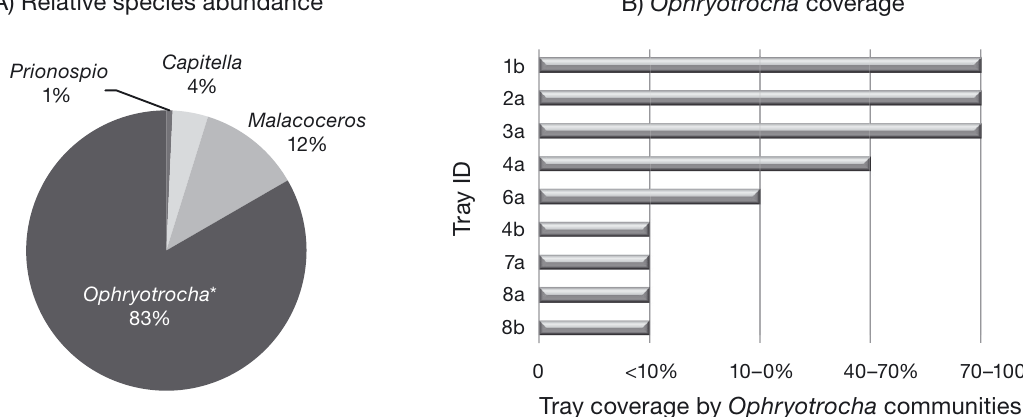
Fig. 2. Polychaete development on benthic cultivation trays. (A) Relative species abundance (% based on number m −2 ) deter- mined after retrieval of the cultivation trays. Abundance of Ophryotrocha spp. is underestimated, as an unknown fraction of in- dividuals was lost during retrieval from deployment depth to the surface. (B) In situ measurement of Ophryotrocha coverage (%) on each tray as determined by video analysis prior to sampling (4 wk deployment) and defined by the coverage of the tray sur- face by the Ophryotrocha complexes (polychaetes including mucus). Tray ID refers to the cage number to which the tray was connected. Trays were placed (a) on the south side of each of the 8 salmon cages, and (b) additional trays were placed on the north side below cages 1, 2, 4 and 8. The quality of video recordings of Tray 1a, 2b and 5a was not sufficient for categorizing the tray coverage and they were therefore